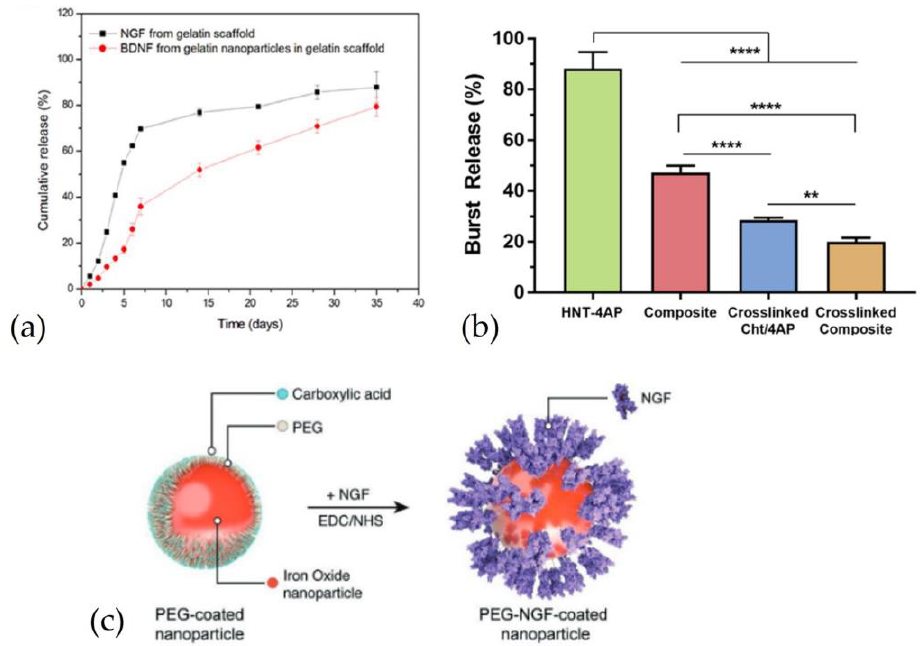
Figure 6. Nanoparticles as drug delivery systems loaded in nerve guidance channels: ( a ) Comparison of release between NGF, incorporated in the scaffold without nanoparticles, and BDNF, incorporated in gelatin nanoparticles loaded in gelatin scaffold. Reproduced and adapted with permission from [71], Copyright© 2017 ACS Publications. ( b ) Comparison of 4-aminopyridine (4-AP) release from halloysite nanotubes (HNT-4AP), HNTs incorporated in the chitosan conduit without crosslinked (composite), chitosan conduit crosslinked (crosslinked Cht/4AP) and HNTs incorpo- rated in the chitosan conduit crosslinked (crosslinked composite) (** = p < 0.01; **** = p < 0.0001). Reproduced and adapted with permission from [7], Copyright© 2019 Elsevier B.V. ( c ) Representa- tion of magnetic nanoparticles coated with PEG and linked to NGF. Reproduced and adapted with permission from [76], Copyright © 1999 – 2023 John Wiley & Sons, Inc. Table 3. Schematic list of nanoparticle studies to enhance nerve regeneration. Drug